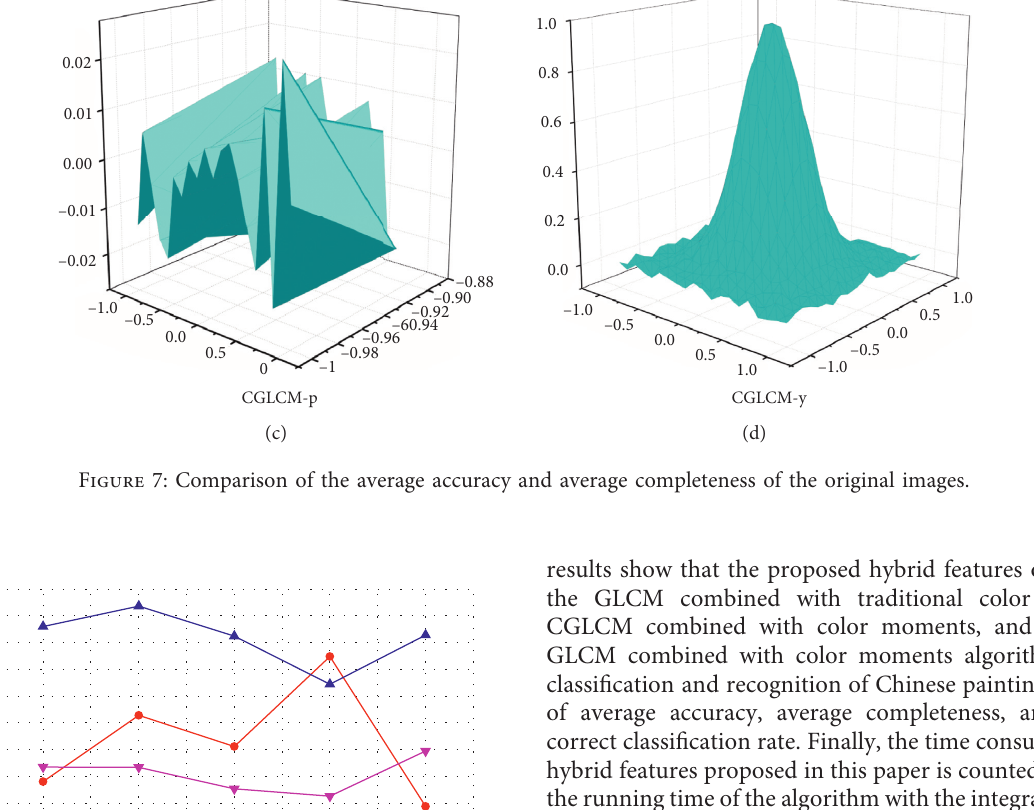
0.00.51.01.52.02.53.0